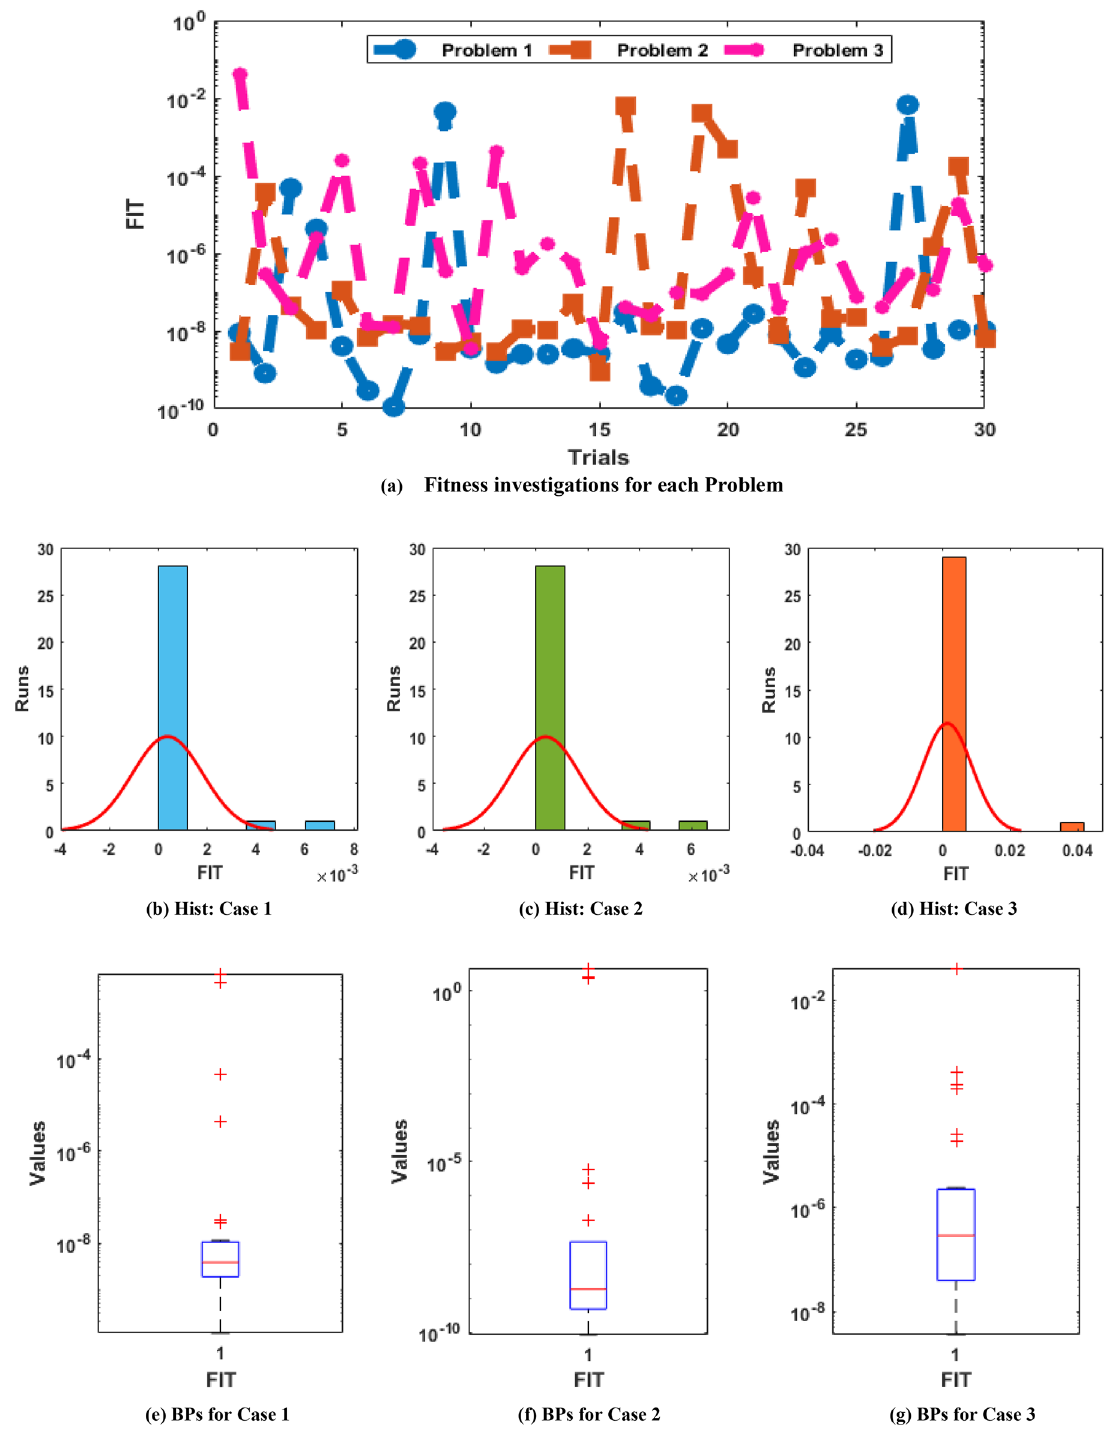
Figure 4. Statistical illustrations via swarming schemes based on the fitness for solving the novel